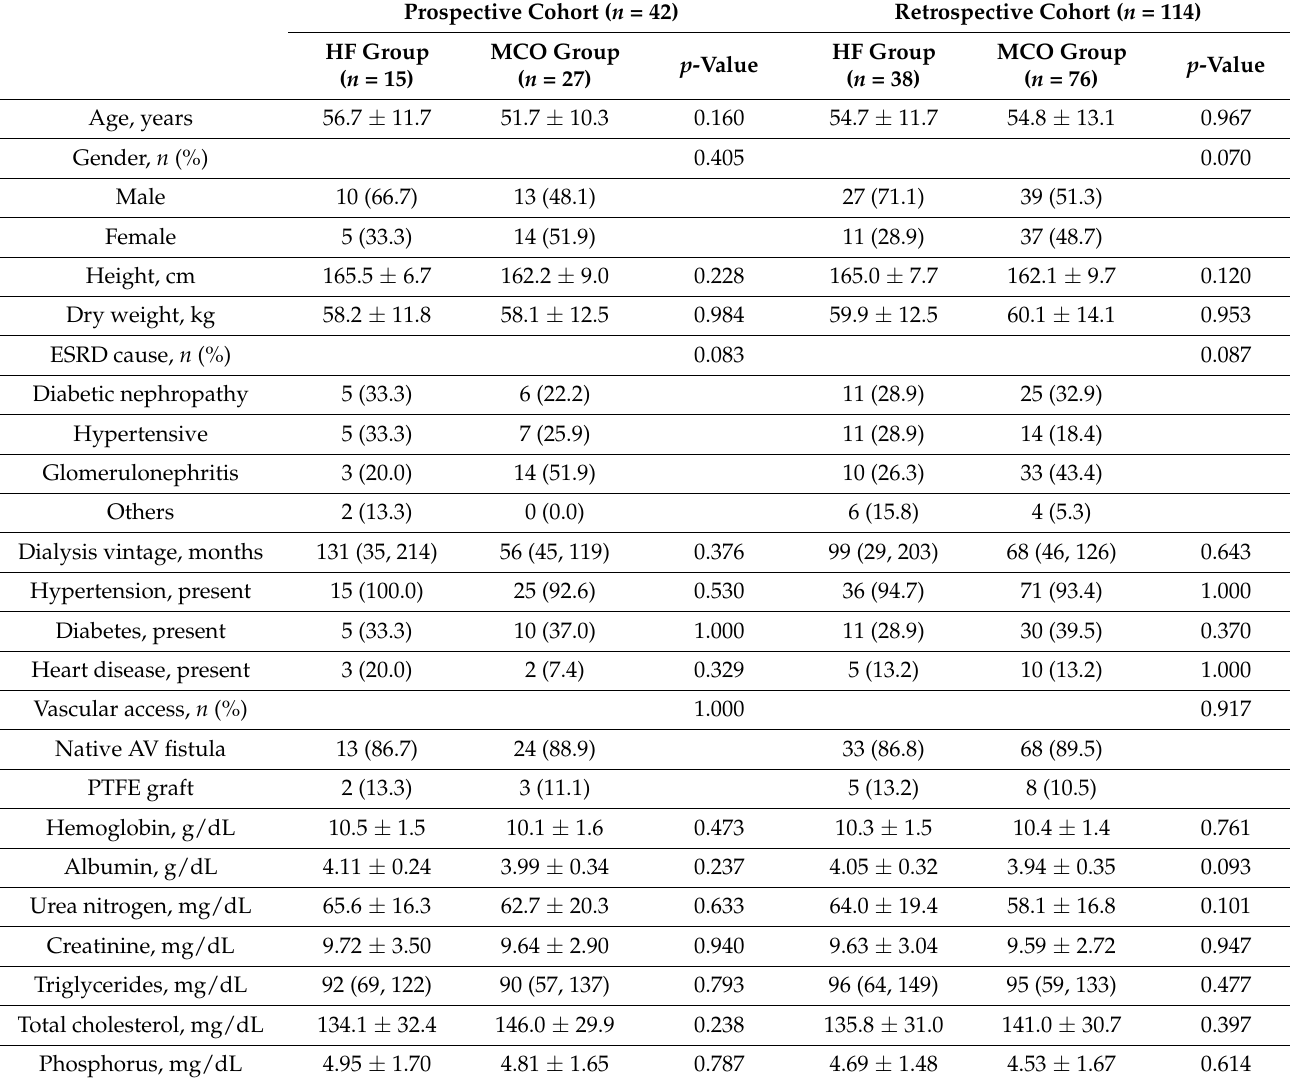
Table 1. Cohort demographics and clinical